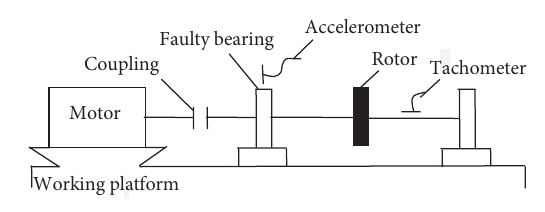
Figure 11: Experimental setup.